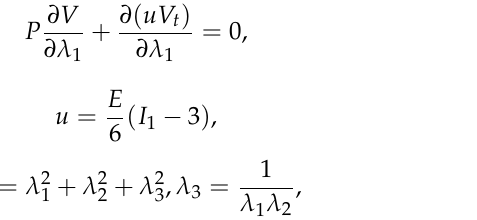
α , δ is the net angular deformation of the actuator’s l , r are the deformed elemental axial * *